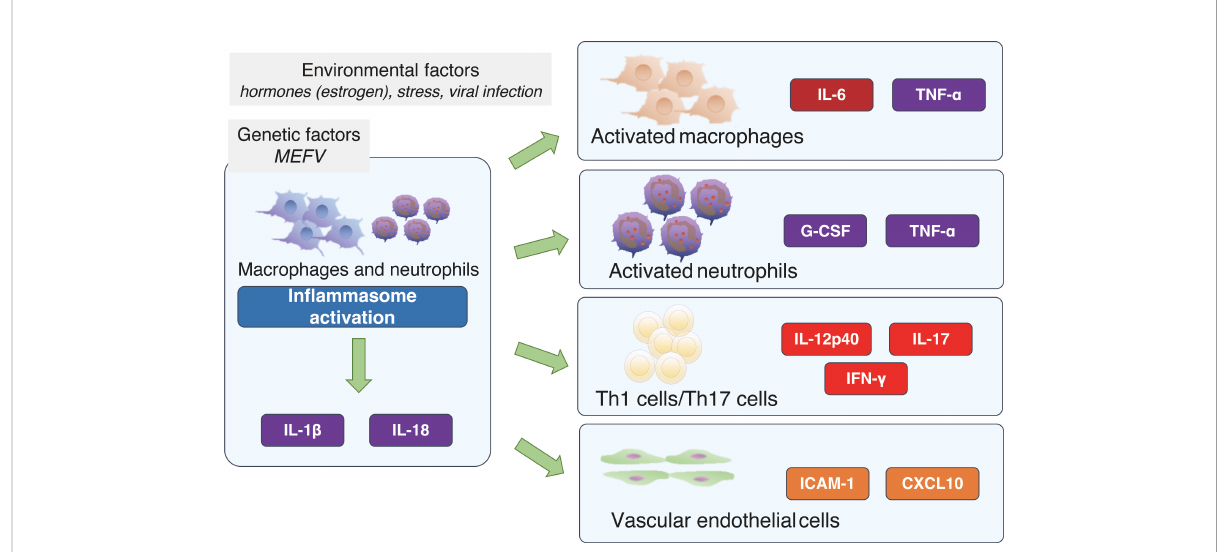
FIGURE 1 Cellular signals associated with in fl ammasome activation and proteins affected by autoin fl ammatory disease-related gene variants. ASC, apoptosis-associated speck-like protein containing a caspase recruitment domain; CAPS, cryopyrin-associated periodic syndrome; DAMPs, damage-associated molecular patterns; FMF, familial Mediterranean fever; IL, interleukin; IL-1R, interleukin-1 beta receptor; NLRP3, nucleotide- binding oligomerization domain-like receptor protein 3; PAMPs, pathogen-associated molecular patterns; SAA, serum amyloid A; TNF, tumor necrosis factor; TNFR, tumor necrosis factor receptor; TRAPS, TNF receptor-associated periodic